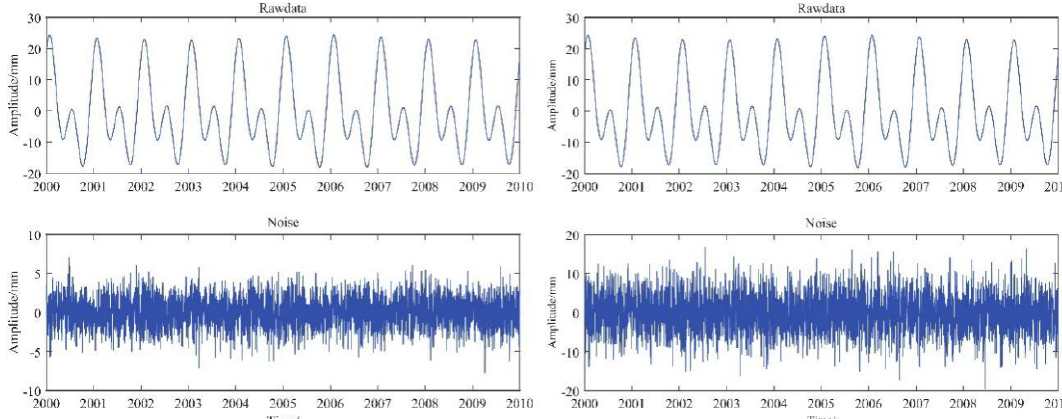
Figure 11. Simulation data II ( left ) and III ( right ) are the signal sequences on the top; the left and right are the same. The bottom is the respective noise, the left is white noise of 4 dB, and the right is the power law- and white noise (PL+WN)-type noise (white noise amplitude is 5 mm, colored noise amplitude 0.02 mm, the spectral index of power law noise is −1.2).